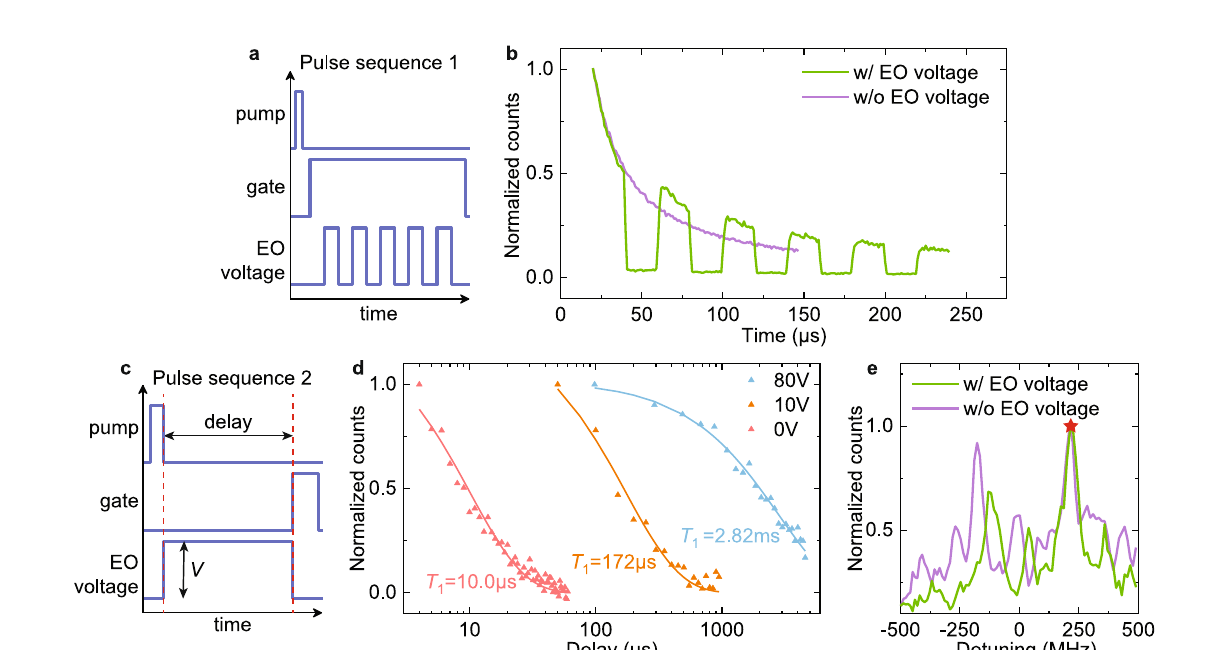
inhomogeneous broadening, at 1534.064 nm. Discrete peaks suggest single ion emission. The star mark indicates the point for g (2) measurement. d Second-order autocorrelationfunction g (2) forthesingleionemission.The x axisisthenumberof offsetbetweenexcitationpulses, y axisisnormalizedcoincidence.Calculatedvalue of g (2) (0)=0.38±0.08 proves that most of the collected photons come from a single ion. The data is symmetric around zero since a single detector is used. The error bars show the standard deviation of the measurement results.